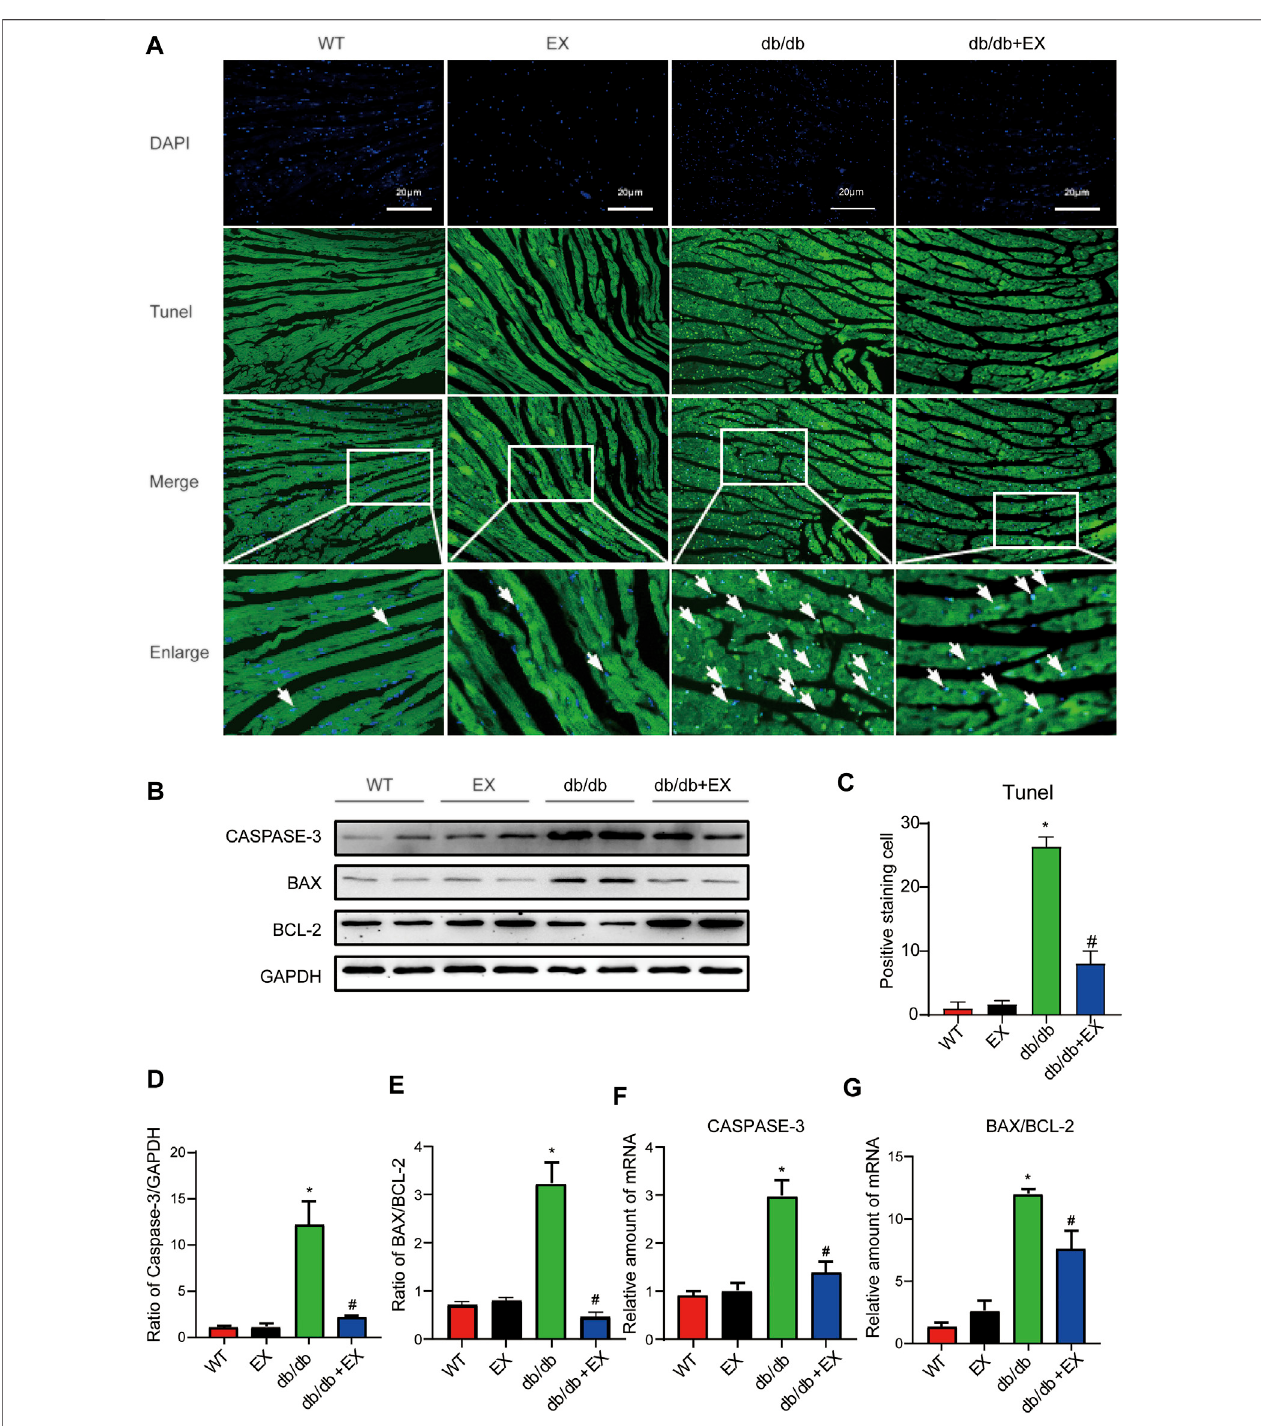
FIGURE 4 | Exercise alleviated cardiomyocyte apoptosis in db/db mice. (A) TUNEL staining and quantitative analysis of myocardial tissue in mice (C) ; (B,D,E) Westernblotanalysiswasperformedtodetectapoptosis-relatedproteins(Caspase-3,Bcl-2,andBax). (F,G) Geneexpressionofapoptoticprotein.* p < 0.05vs.theWT group, # p < 0.05 vs. the db/db